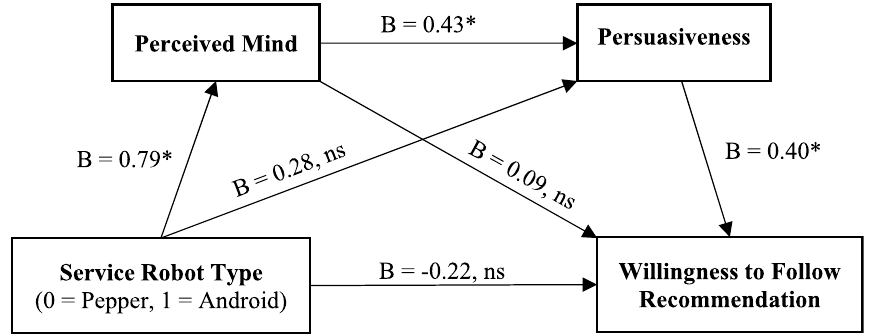
Figure 3. Study 2b: sequential mediation of service robot type on willingness to follow recommendation through perceived mind and persuasiveness (controlled for language type). *p <